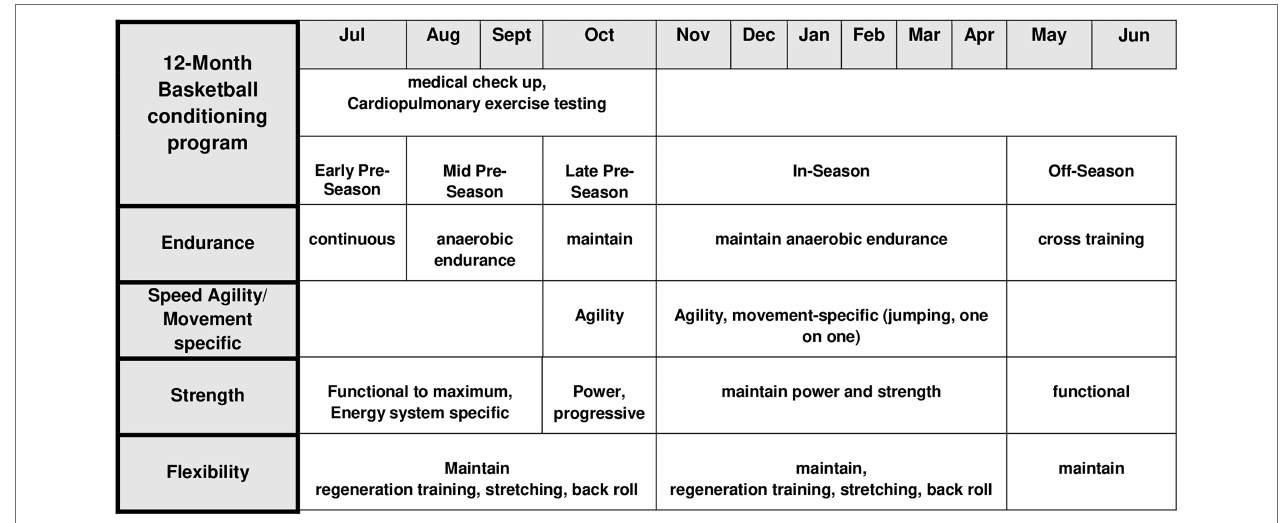
FIGURE 5 | Example of a 12—month basketball training